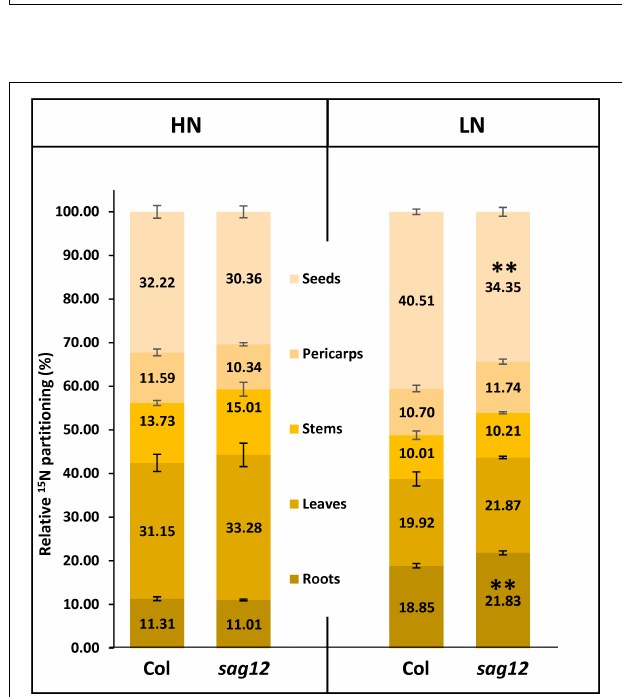
FIGURE 2 | Nitrogen uptake capacities by HATS and LATS are similar in Col and sag12. Col (black bars) and sag12 (white bars) plants were harvested at the vegetative ( n = 12) and reproductive stages ( n = 8). N uptake capacities by high (HATS) and low (LATS) affinity transport systems are presented as means ± SE. Different letters indicate statistically significant differences according to Student’s t -test ( p ≤ 0.05).